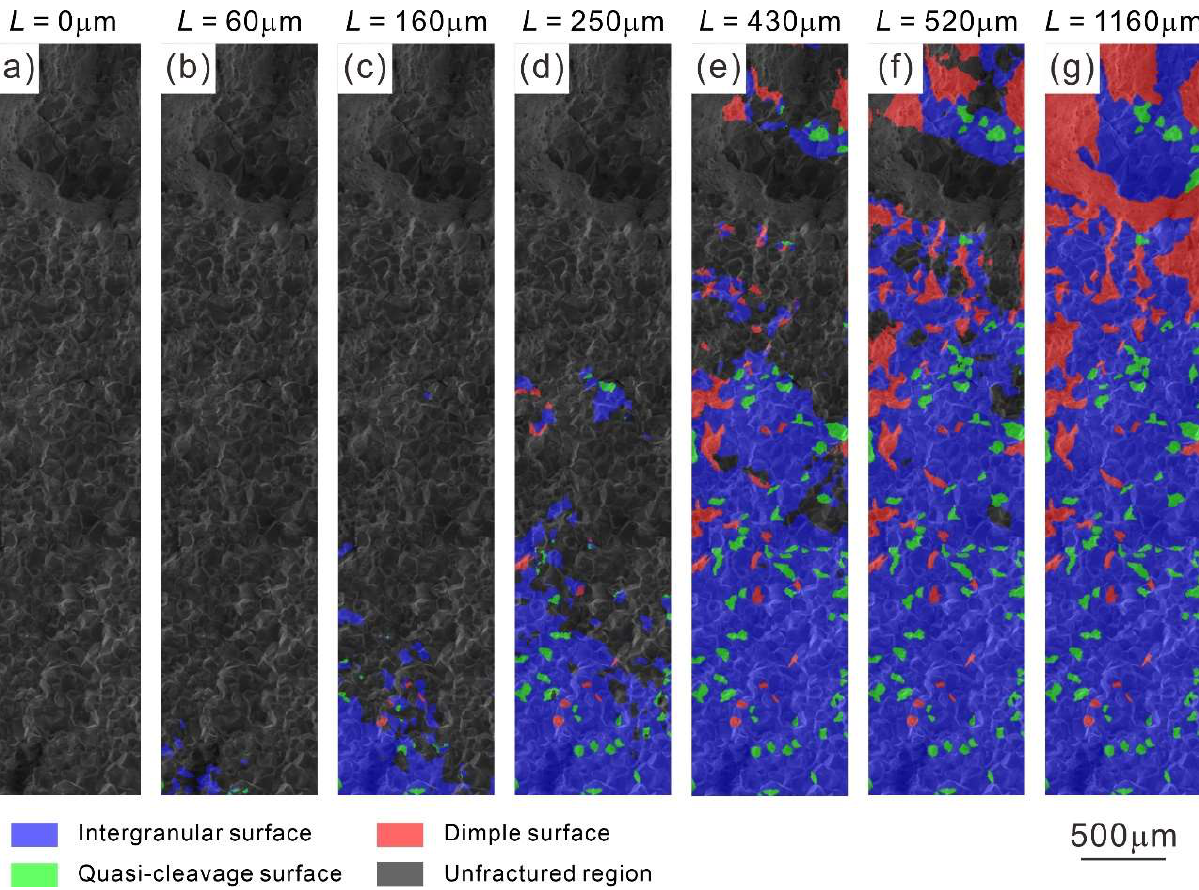
Figure 4. Fracture propagation process reconstructed by FRASTA in the specimen with H D = 0.80 wt. ppm after the constant loading tensile test with an applied stress of 400 MPa (lower than the 0.2% proof stress). The fractured areas (blue: intergranular fracture, green: quasi-cleavage fracture, and red: ductile fracture) are superimposed on the fracture surface SEM images. L in the figure is the distance between the two fracture surface topographic maps; ( a ) 0 µ m, ( b ) 60 µ m, ( c ) 160 µ m, ( d ) 250 µ m, ( e ) 430 µ m, ( f ) 520 µ m, and ( g ) 1160 µ